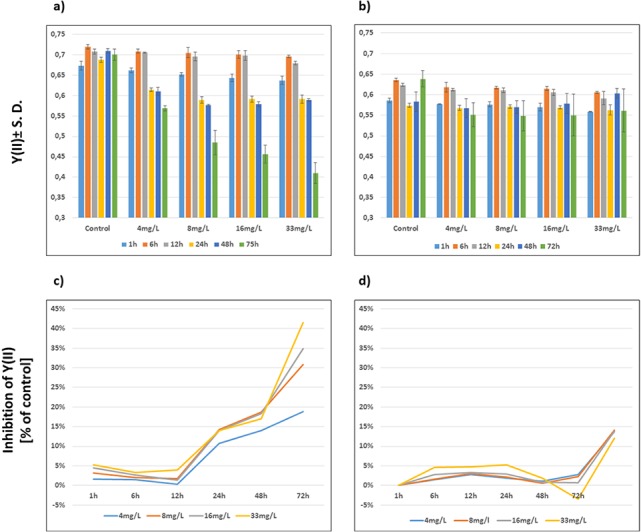
Evolution of photosynthetic parameters.Graphical representation of the effect of beryllium on Y(II) ± S.D (A, B) and % of Y(II) inhibition compared to control (C, D) of wild-type (A, C) and Be-resistant (B, D) Chlamydomonas sp. strains. Measurements were obtained by using a modulated amplitude pulse fluorimeter (Imaging-PAM) at different beryllium concentrations (4, 8, 16, and 33 mg/l) and different times (1, 6, 12, 24, 48, and 72 h).